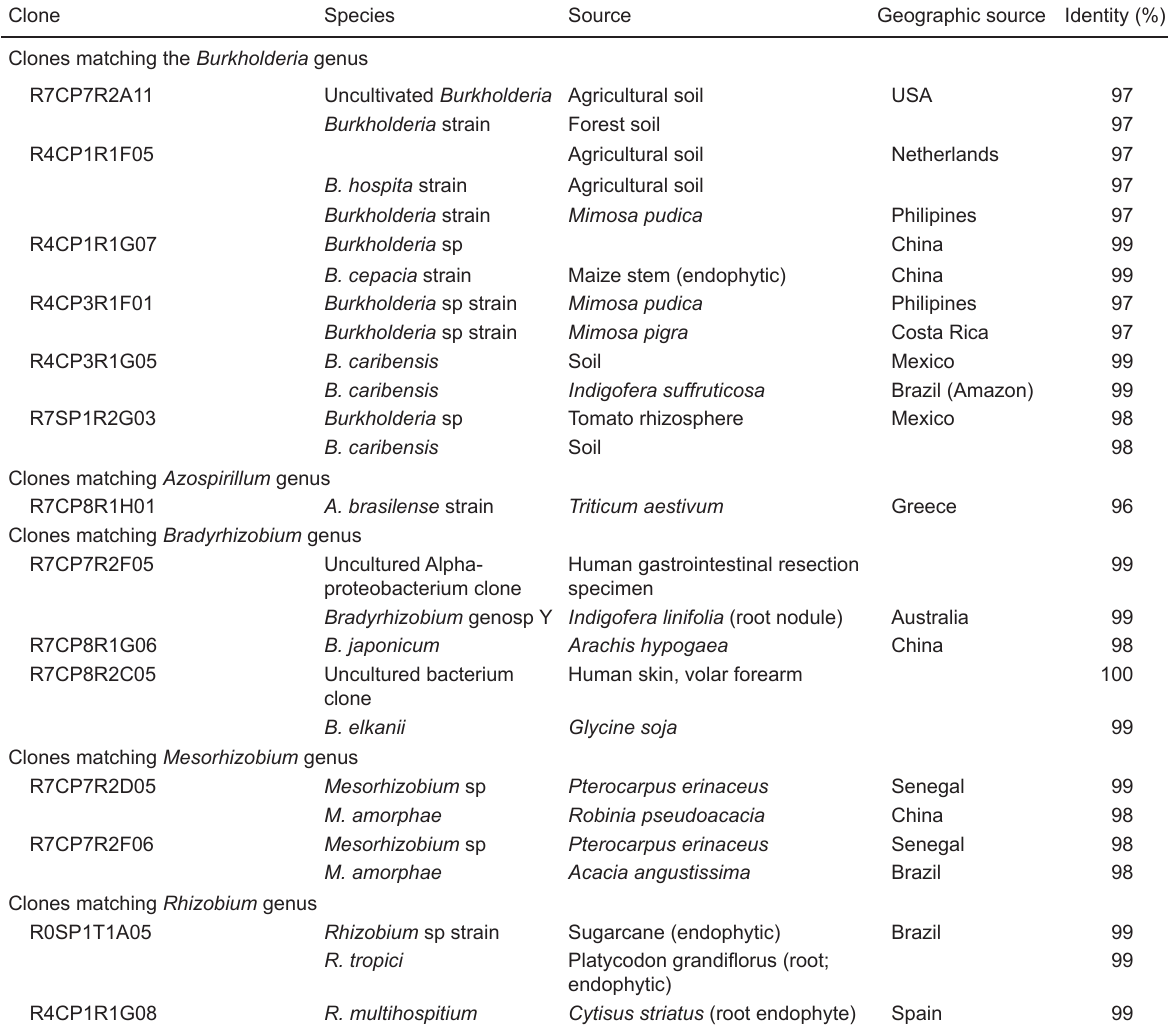
Table 4. MEGA-BLAST results for clones identified as symbiotic and associative